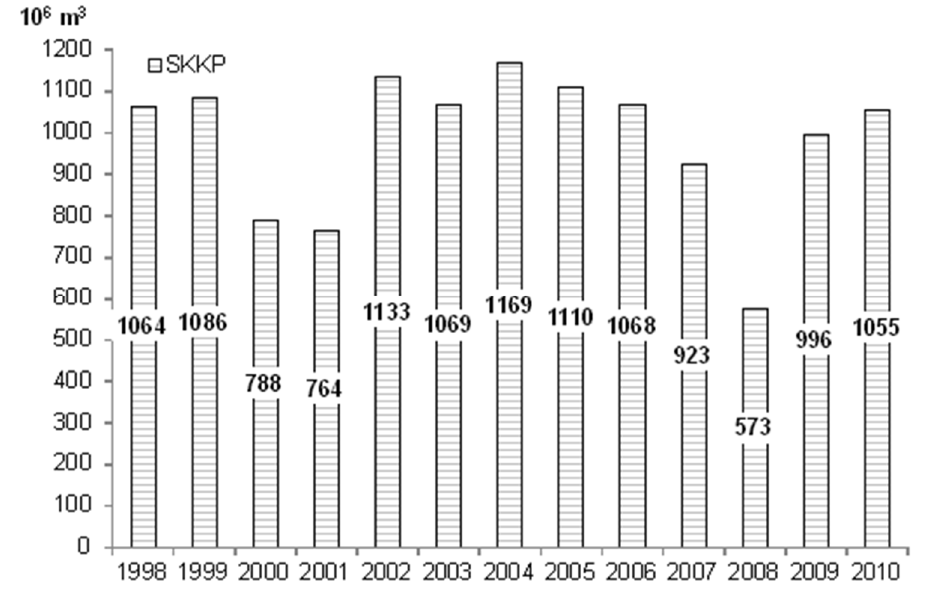
Figure 2. Total irrigation water use in southern Karakalpakstan during the vegetation periods of